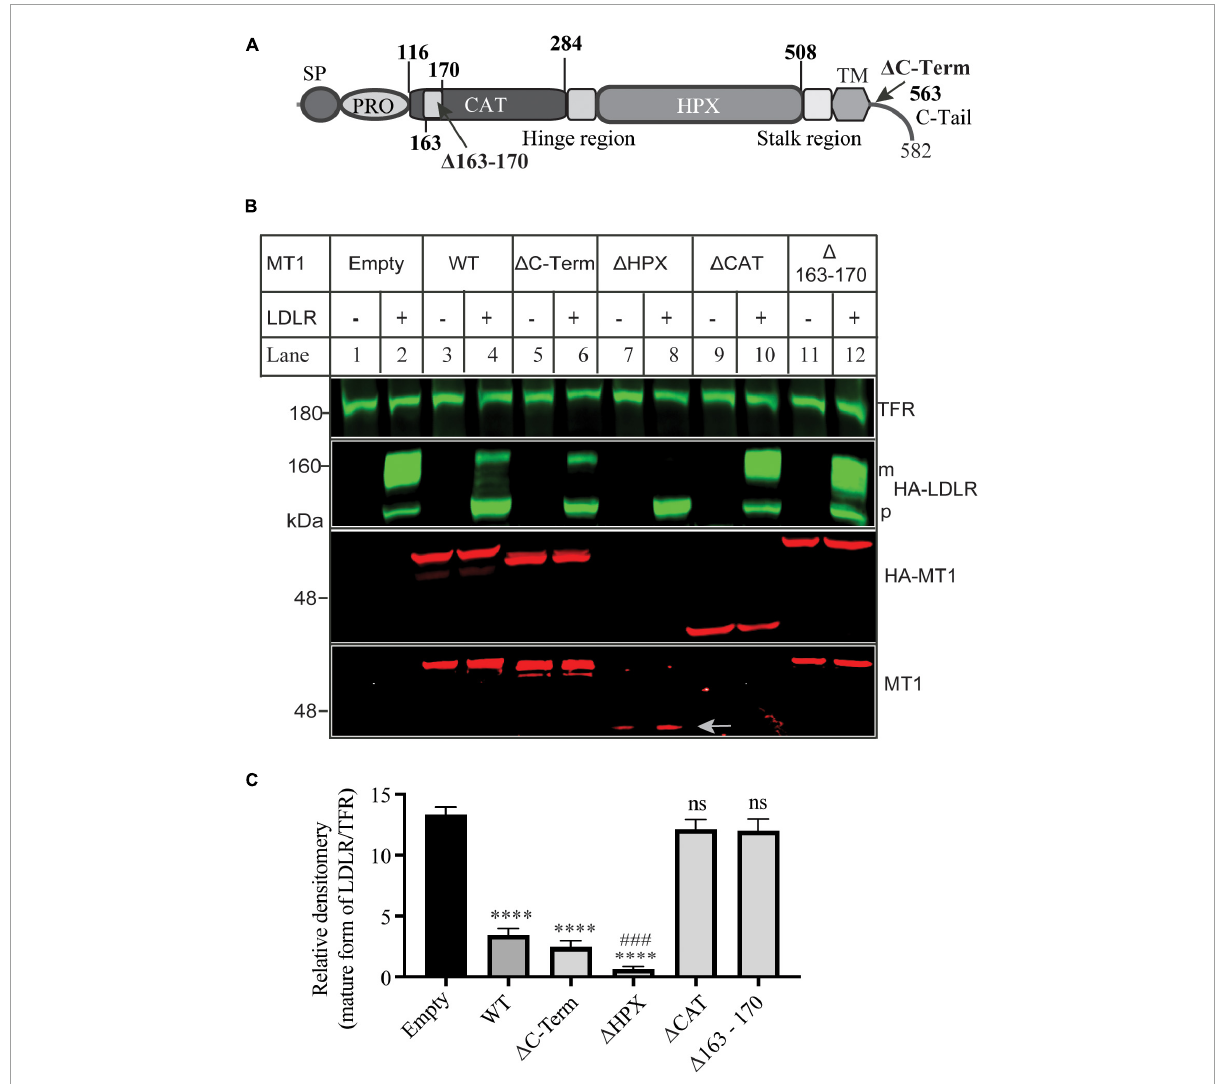
FIGURE3 Effects of mutations in MT1-MMP on its ability to cleave LDLR (A) Diagram of the functional domains of MT1-MMP. SP, signal peptide. PRO, prodomain. CAT, the catalytic domain. HPX, the hemopexin domain. TM, transmembrane domain. C-Tail, the C-terminal cytoplasmic tail. (B ) Immunoblotting and (C) quantification. Equal amount of plasmid DNA containing the wild-type or mutant MT1-MMP and empty plasmid (-) or the wild-type LDLR-containing plasmid were co-transfected into HEK293 cells using PEI. 48 h later, whole cell lysate was prepared, and equal amount of total proteins in whole cell lysate was applied to immunoblotting. After transfer, the membrane was cut into halves above the 75 kDa protein marker. The top membrane was blotted with a Dylight TM 800-conjugated rabbit anti-HA antibody to recognize HA-LDLR. m: mature form of LDLR; p: premature form of LDLR. The bottom membrane was blotted with a Dylight TM 680-conjugated rabbit anti-HA antibody to detect HA-MT1-MMP (HA-MT1). The bottom part was also blotted with a mouse anti-MT1-MMP antibody to detect MT1-MMP (MT1) (EMD Millipore, MAB3329). TFR, transferrin receptor (TFR). Representative images were shown (B) . Densitometry was determined by a Li-Cor Odyssey Infrared Imaging System. Relative densitometry was defined as the ratio of the densitometry of the mature form (m) of LDLR to that of TFR